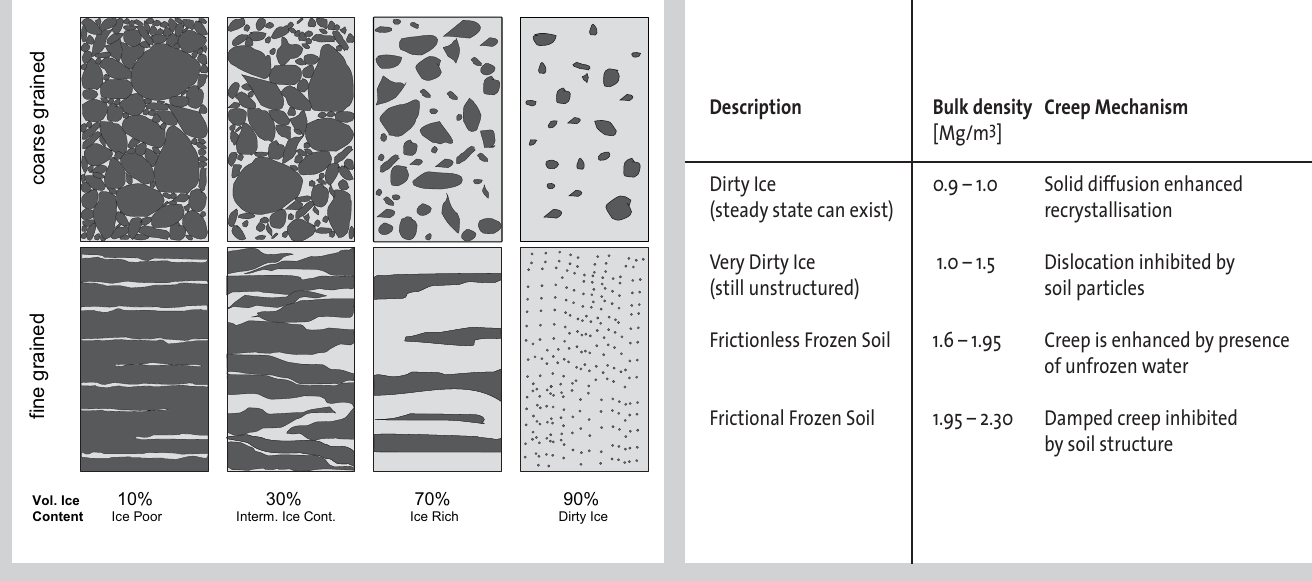
Figure 3: Schematic representation of frozen soil samples at different volumetric ice contents. Table 1: Frozen soil classification according to Weaver